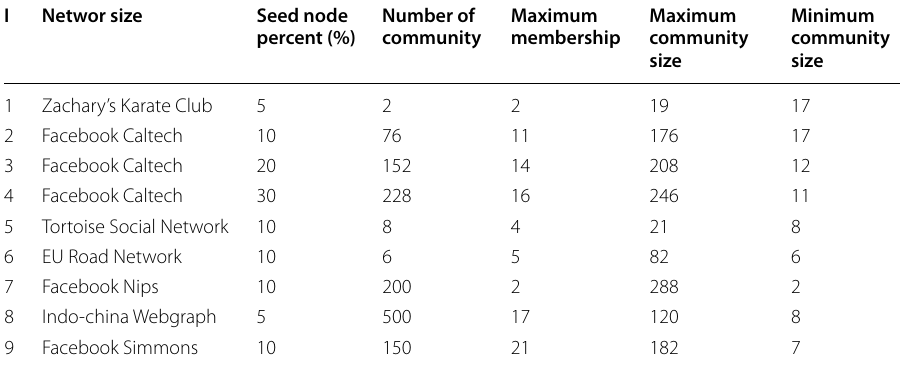
Also, here α = 0.75 and ν = 0.6 for all the entries in the table